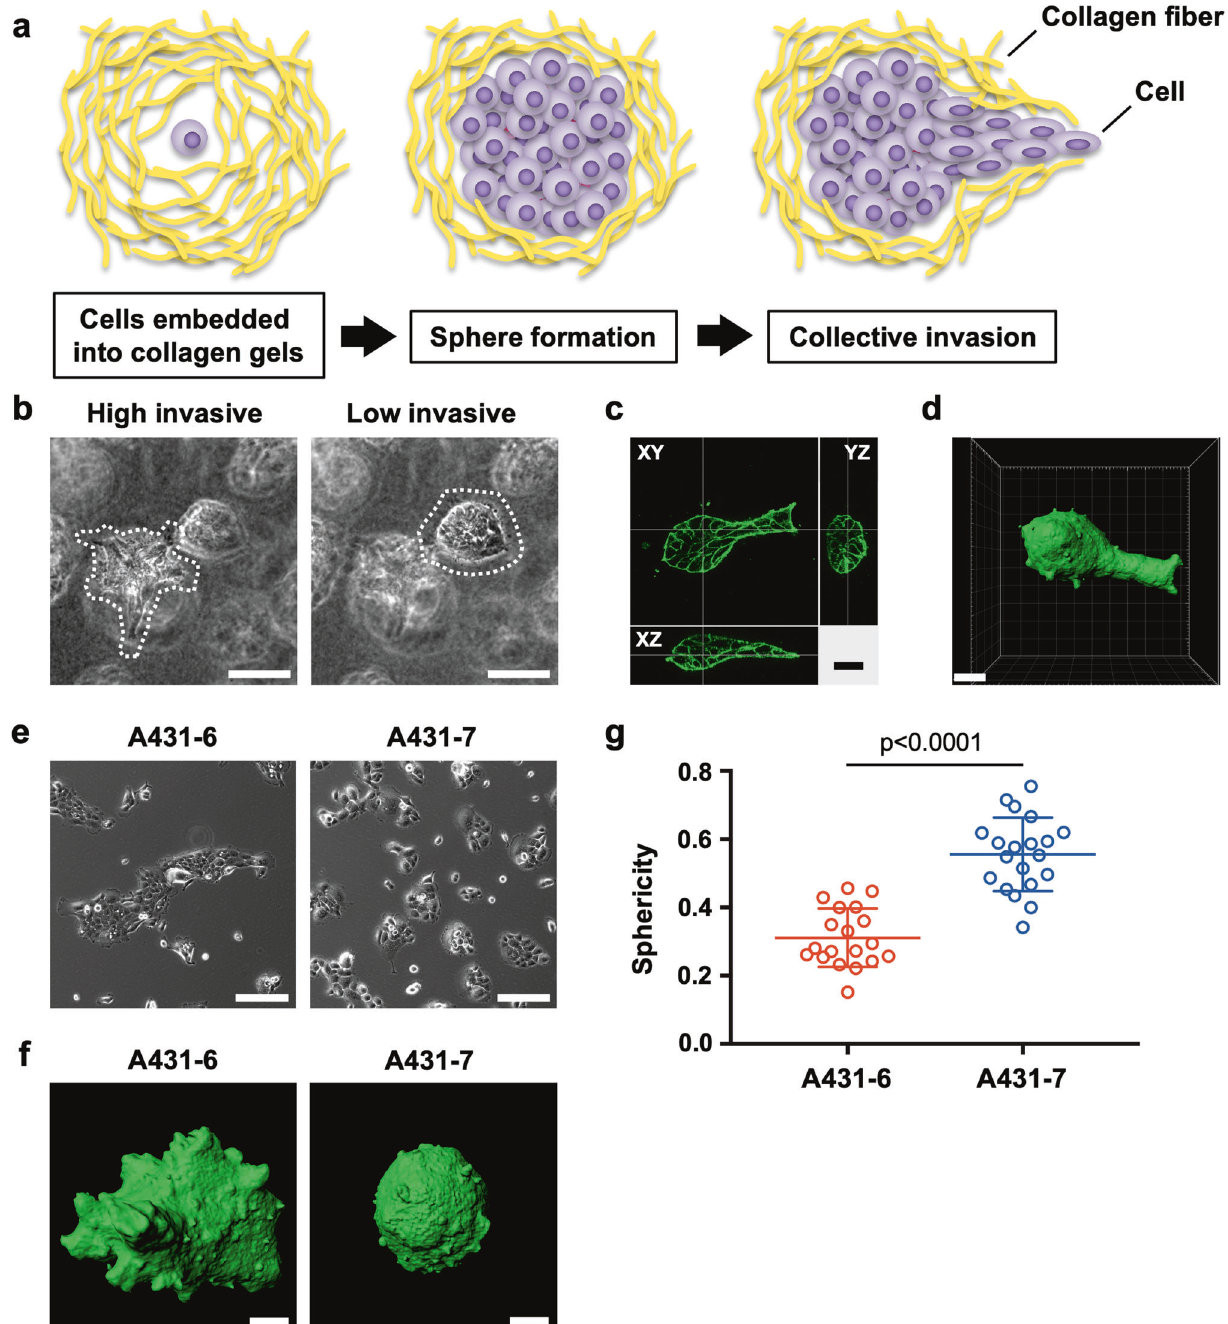
Fig. 1 Establishment of subclones with high- or low-invasive potentials from A431 cells consisted of heterogeneous cells. a Schematic illustration of the experimental system to assess collective invasion. b Representative phase-contrast images of the invasive cell cluster (left) and non-invasive cell cluster (right) in A431-WT cells cultured in a three-dimensional collagen gel culture system; both were captured in the same fi eld. The dotted lines show the contours of the cell clusters. Scale bars represent 100 µm. c F-actin staining of the invasive cell cluster in A431-WT cells cultured in three-dimensional collagen gel culture with XY, YZ, and XZ sectional views. Scale bar represents 25 µm. d Three- dimensional constructed image of ( c ) using the Imaris software. Scale bar represents 30 µm. e Phase contrast images of the high-invasive A431-6 and low-invasive A431-7 subclones. Scale bars represent 200 µm. f Representative three-dimensional constructed images of A431-6 and A431-7 cell clusters cultured in a three-dimensional collagen gel culture system. The sphericity of A431-6: 0.221 and A431-7: 0.715. Scale bars represent 30 µm. g Quanti fi cation of sphericity in ( f ). Lines show the mean with standard deviation (SD) for n = 19 (A431-6) and n = 19 (A431-7) clusters by two independent